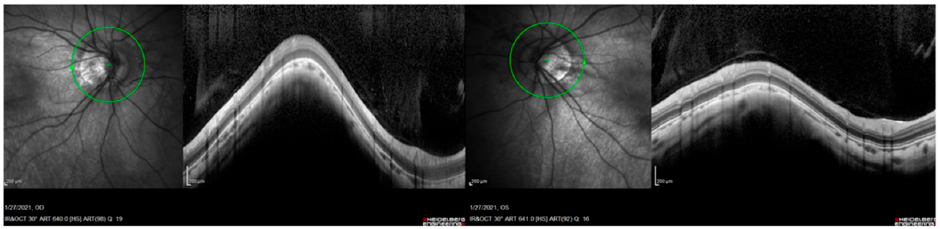
Figure 2. Diffuse chorioretinal atrophy. Right and left eyes. Optos (Marlborough, MA, USA).